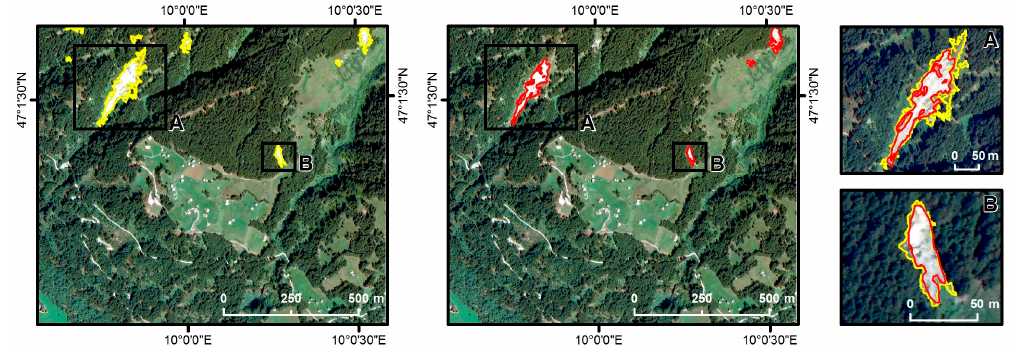
Figure 4. Semi-automatically mapped landslides using the object-based image analysis (OBIA) approach (in yellow; left ) and manually mapped landslides (in red; middle ) for study area III based on the WorldView-2 image. Two subsets demonstrating the variation of the mapping results for selected landslides are shown on the right . The black rectangles (A, B) indicate the location of the subsets.